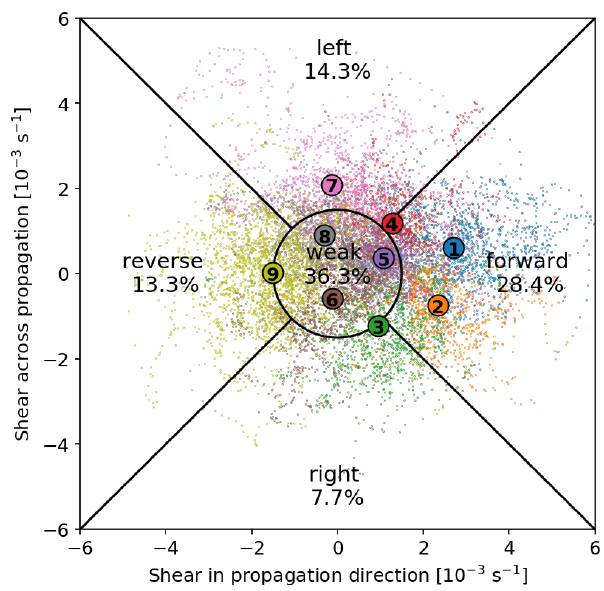
Figure 4. The categorisation along the vertical-shear vector (Eq. 4). The mean value of the shear vector of all time steps associated with each node is marked by a coloured circle labelled with the number of the node. The shear vector of each individual polar-low time step is displayed as a small dot in the colour that represents the SOM node of the time step. The black circle and lines divide the shear- vector space into the categories forward-shear, right-shear, reverse- shear, left-shear, and weak-shear situations. The fraction of time steps associated with each category is